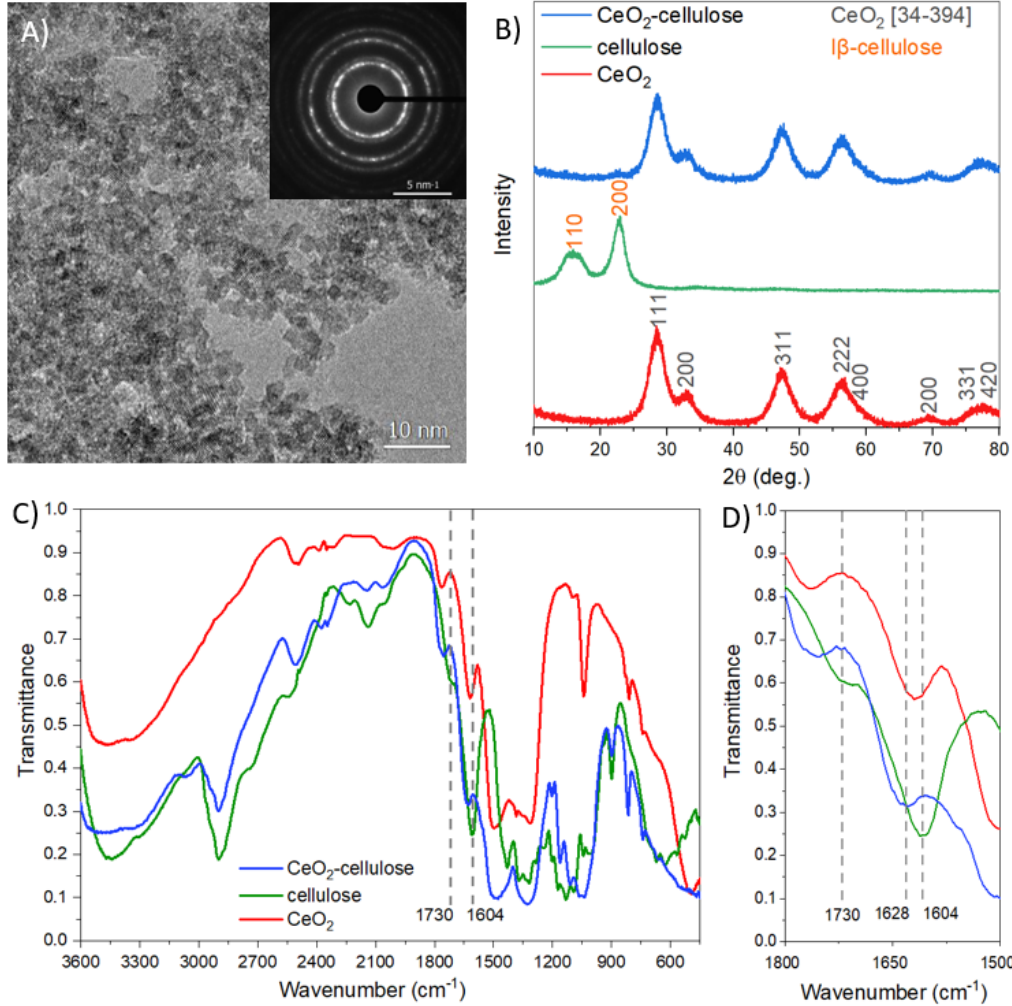
Figure 3. TEM image of initial CeO 2 nanoparticles and the corresponding electron diffraction pattern (insert) ( A ), X-ray diffraction patterns ( B ), survey ( C ) and detailed ( D ) FTIR spectra of CeO 2 nanoparticles, cellulose and CeO 2 /cellulose com- posite.